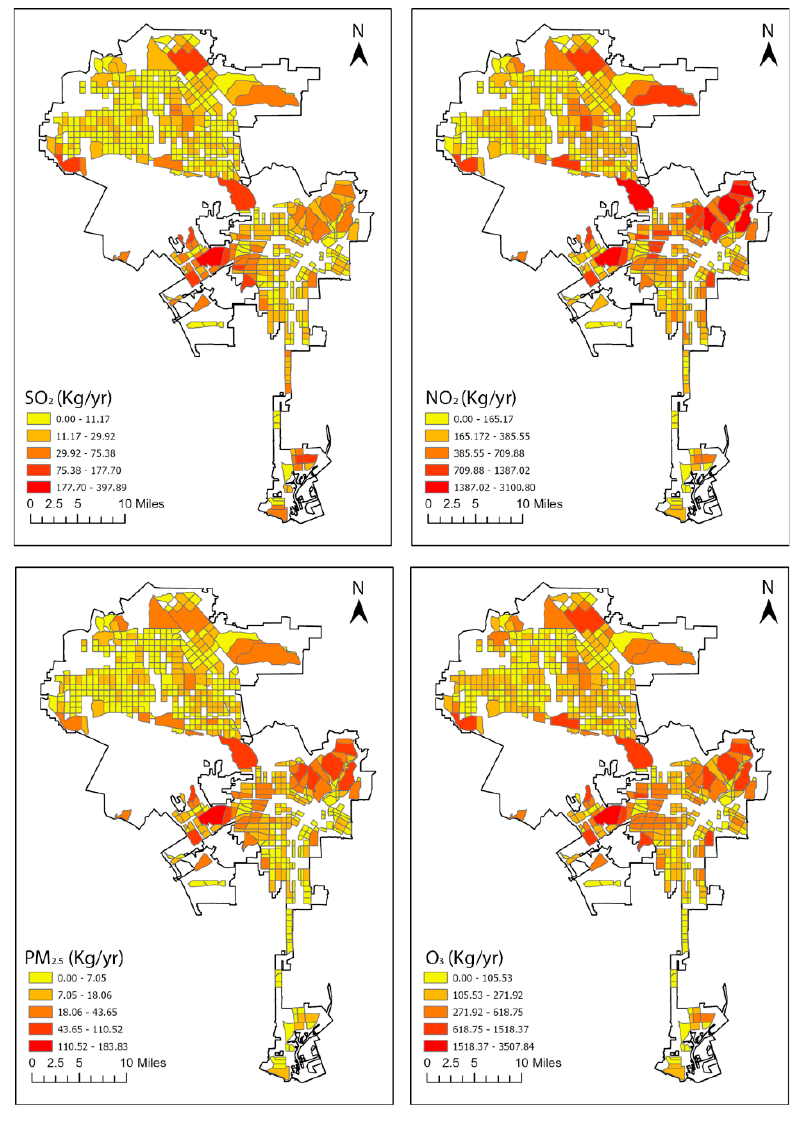
Figure 3. Annual air pollutant reductions from increasing tree cover estimated by i-Tree tools.